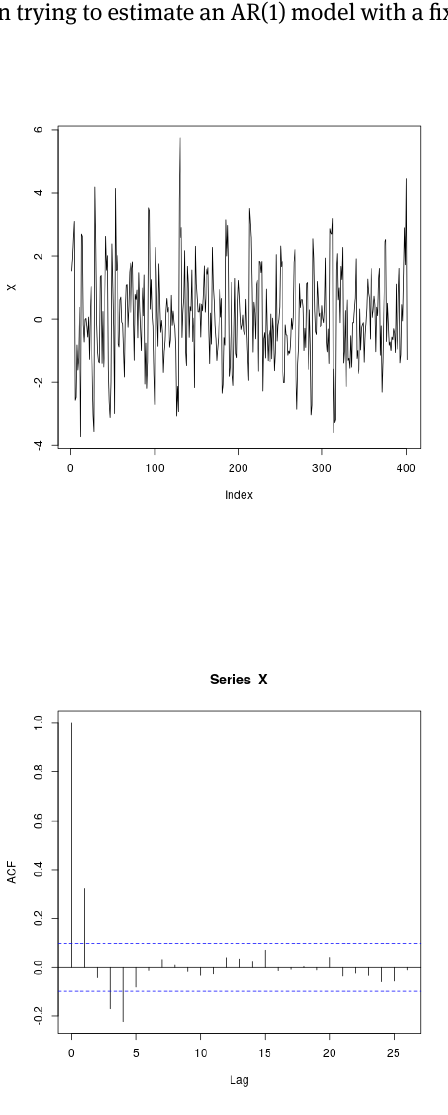
Figure 2: Autocorrelation function of the